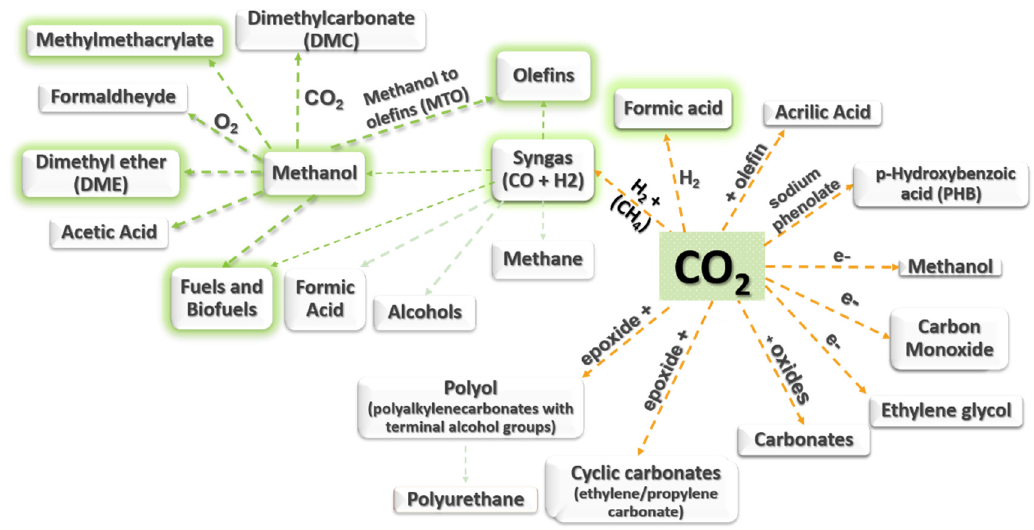
Figure 20. Products that can be currently manufactured using CO 2 as a building block.